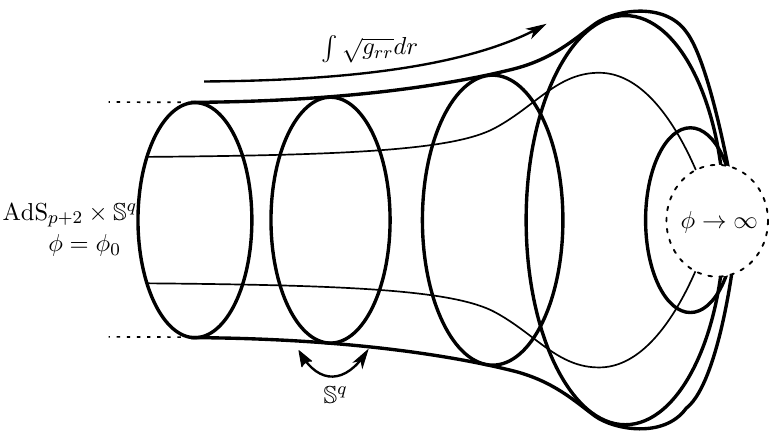
Figure 2 . A schematic depiction of the expected structure of the complete geometry generated by the branes, displaying only geodesic radial distance and the S q radius. The geometry interpolates between the AdS (cid:2) S throat and the pinch-o(cid:11) singularity (dashed circle). In terms of the geodesic radial coordinate (cid:26)